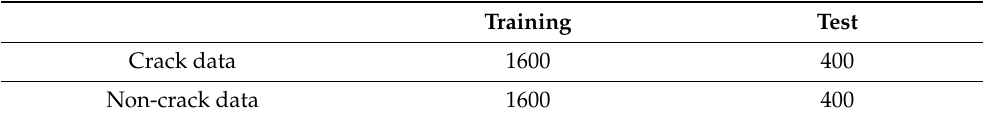
Table 5. Composition of the image data for training and test.